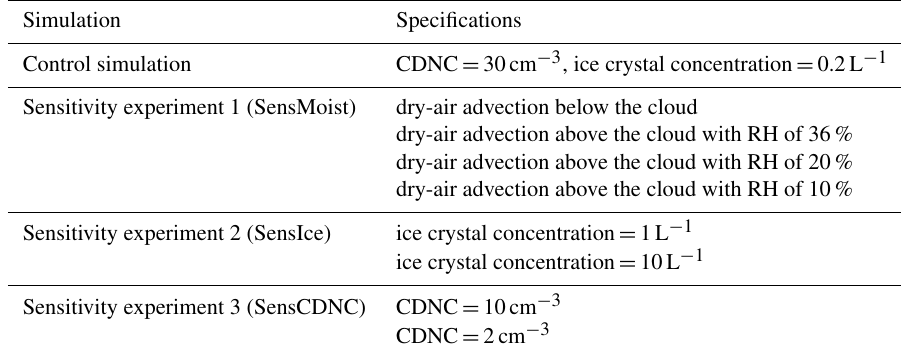
Figure 2. The observed and simulated liquid water path (LWP) (a) and ice water path (IWP) (b) are shown in blue and red, respectively. The simulated LWP includes cloud droplets and raindrops. In the bottom row the cloud phase classification is shown for two different heights, 725m (c) and 950m (d) , during 31 August 2008. The classification number is described as follows: 0: clear; 1: ice; 2: snow; 3: liquid; 4: drizzle; 5: liquid cloud drizzle; 6: rain; 7: mixed phase; 8: haze; and 10: uncertain. Table 1. Overview and short description of the different sensitivity